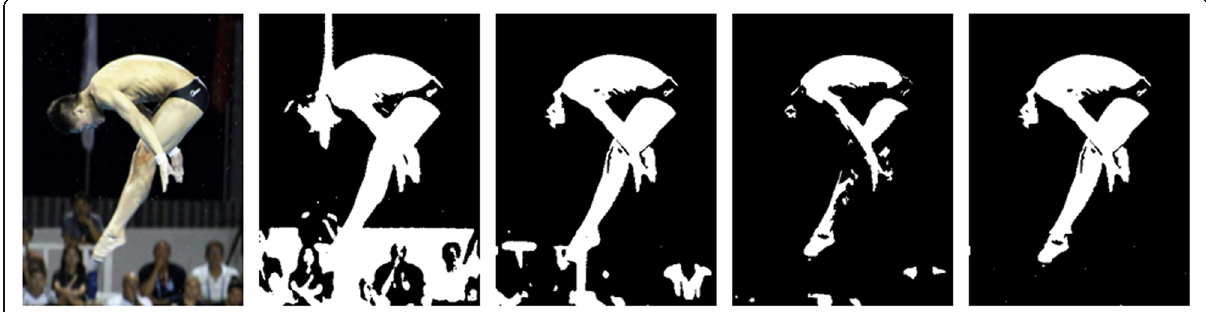
Fig. 7 Comparative analysis of de-drying